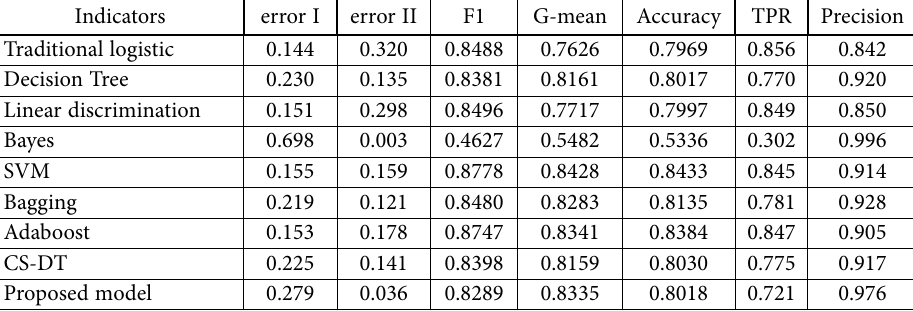
Table 5. Experimental results from the research dataset